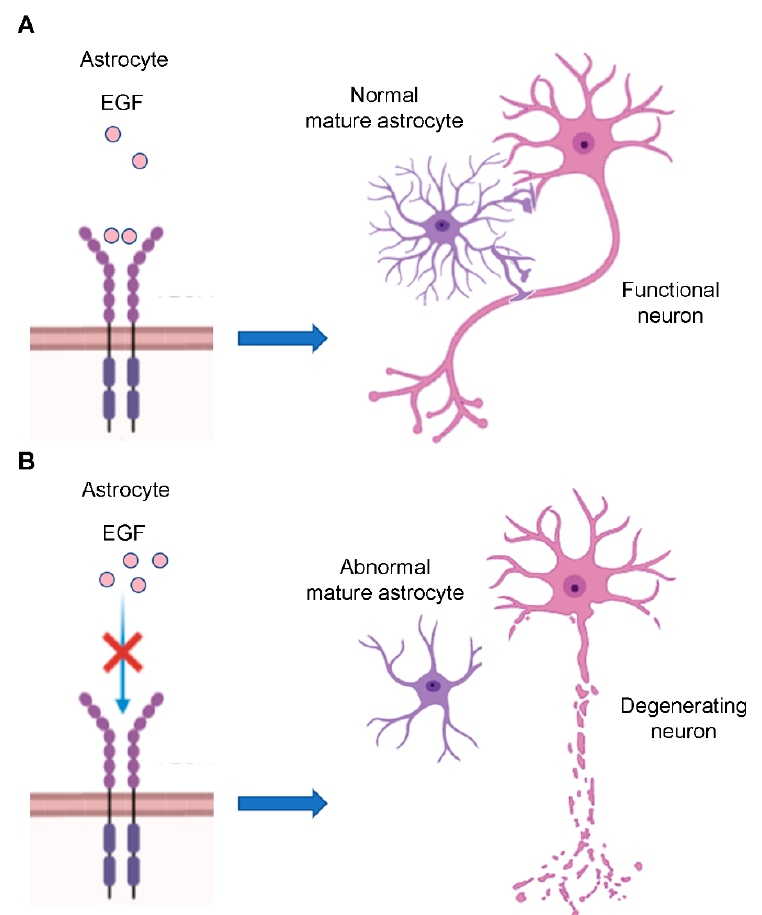
Figure 5. EGFR regulate astrocyte morphology. ( A ) Mature astrocytes show cribriform structures which surround axons sustaining neuronal functions. EGFR signaling stimulates the acquisition of these processes. ( B ) EGFR blockade during CNS development inhibits the formation of astrocytes’ processes leading to neuronal degeneration.